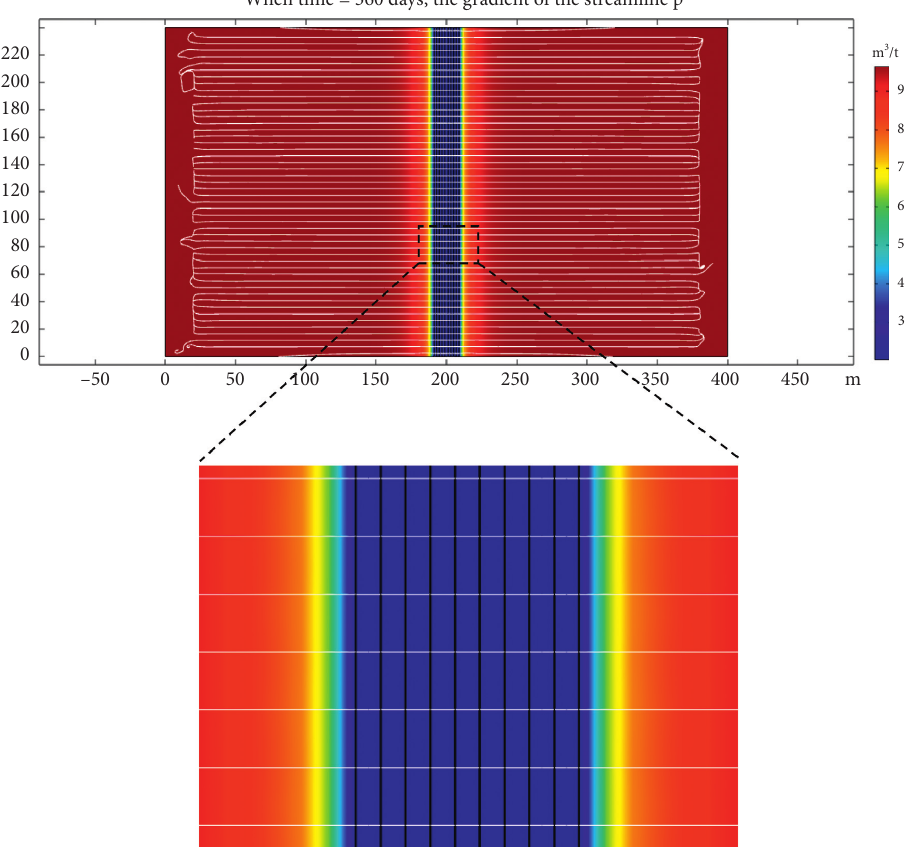
Figure 8: Streamline diagram of the long boreholes along the